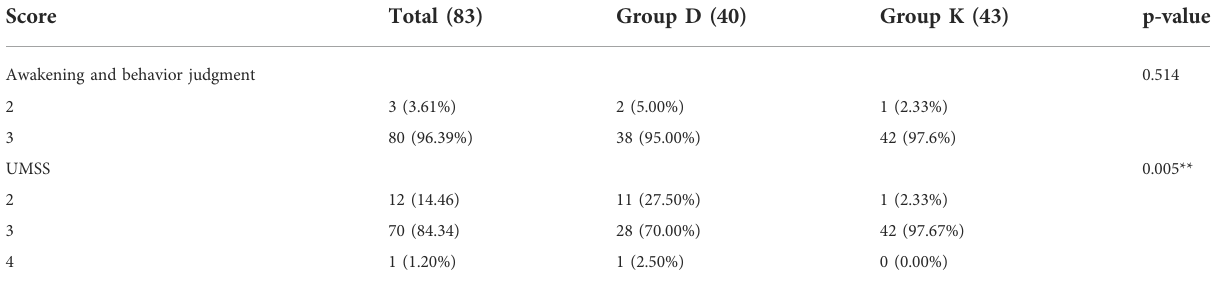
TABLE 3 UMSS score and Awakening and behavior judgment (ABJ) score.